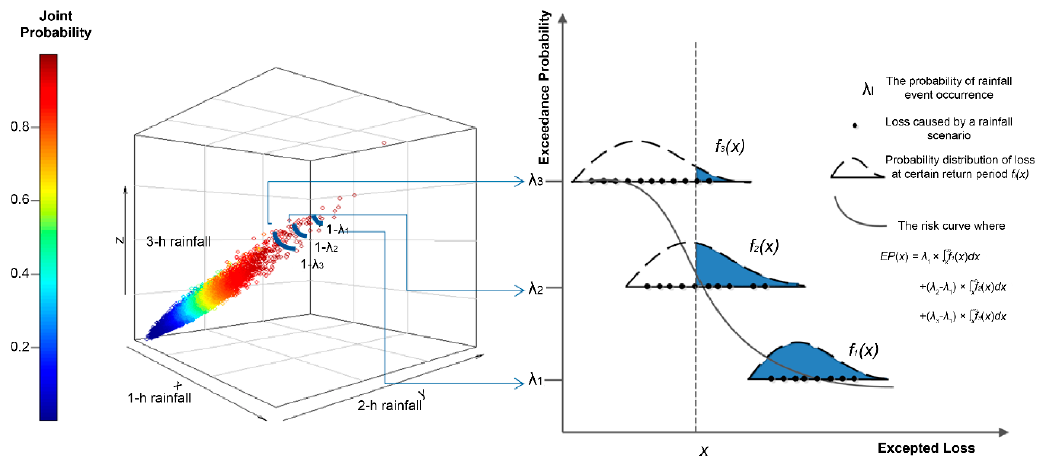
Figure 3. Sketch map of the risk curve.